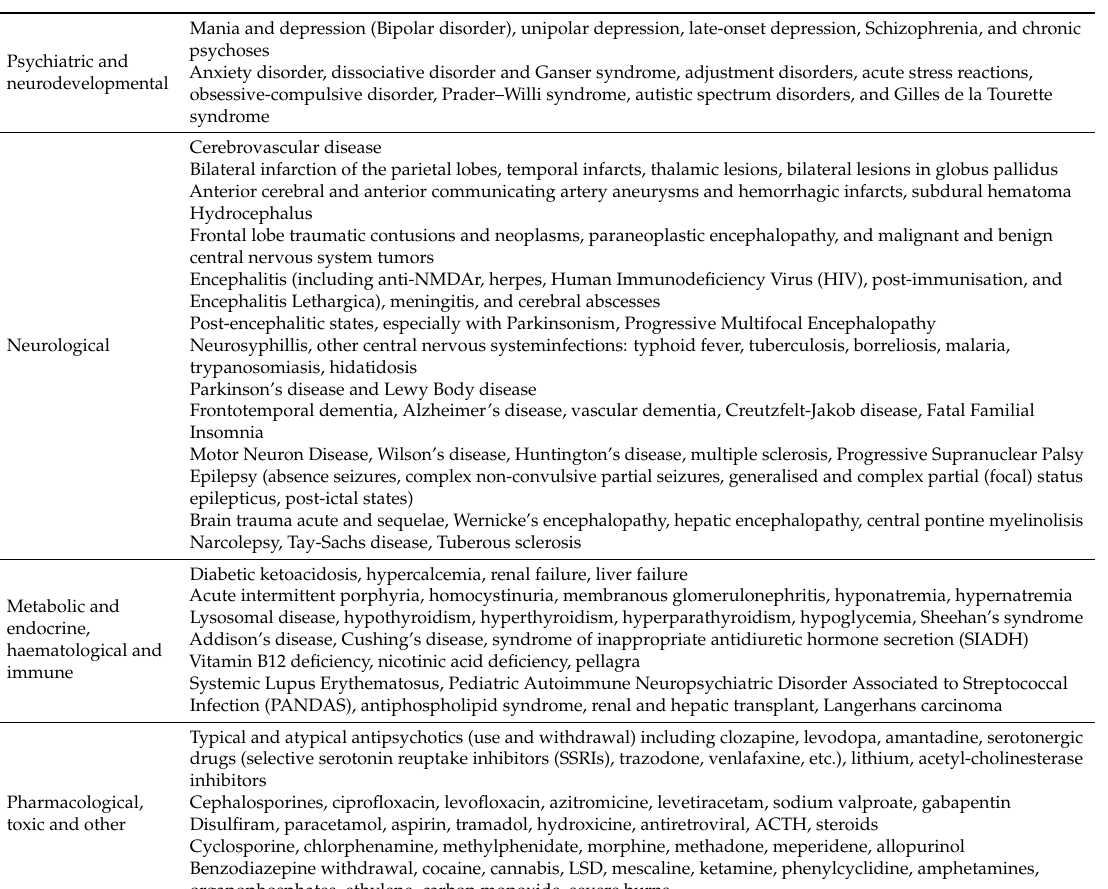
Table 1. Causes of Catatonia (not